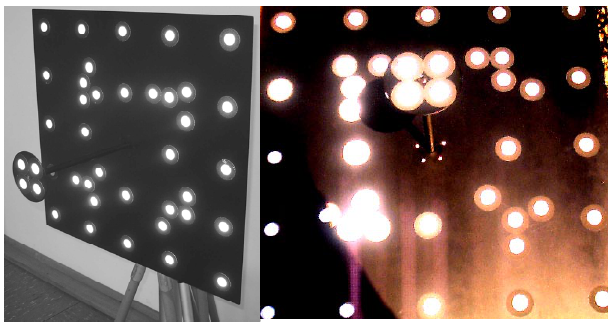
Fig 2 . Images with calibration test field: used test field for calibration; image taken by amateur camera (one of calibrator sets)